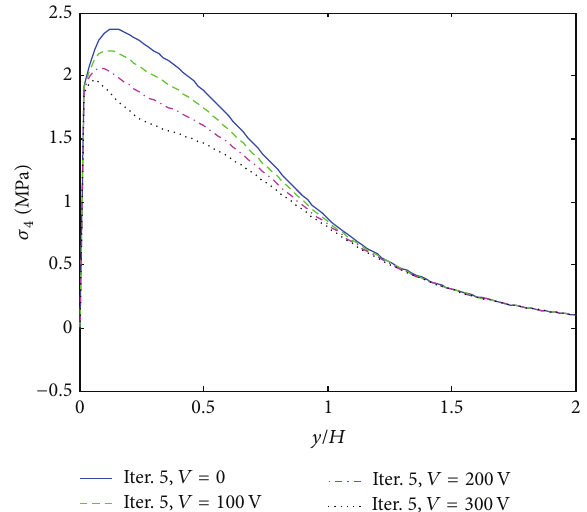
Figure 8: 𝜎 4 distribution of [PZT/0 4 /90 4 ]s laminate at the interface of 𝑧/𝐻 = 1/6 , under 0.1% uniaxial strain.